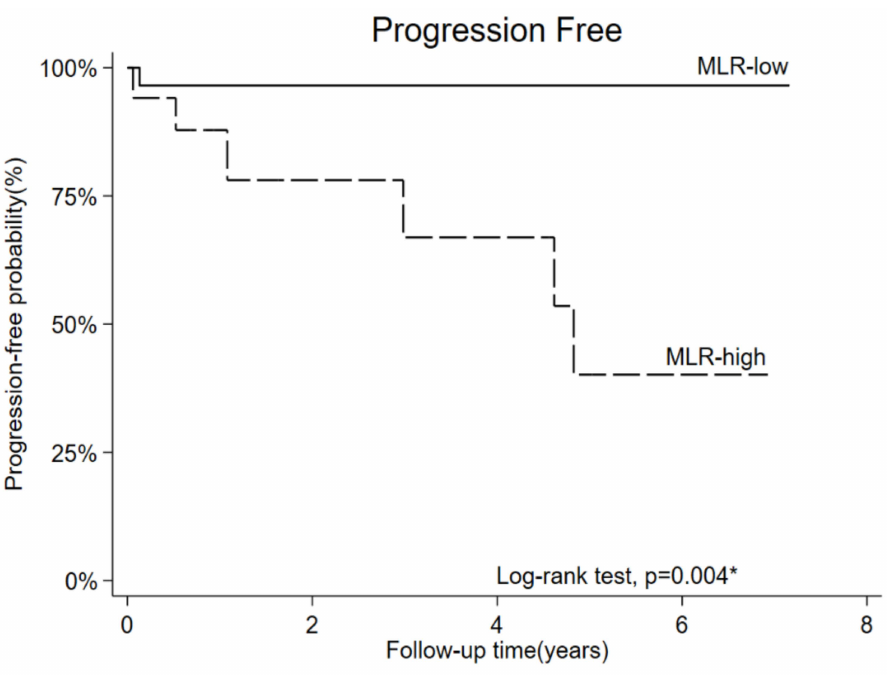
Figure 6. Progression-free survival stratified by high and low monocyte/lymphocyte ratio (MLR) (5-year progress-free survival rate = 96% and 41% in the MLR-low and MLR-high groups,